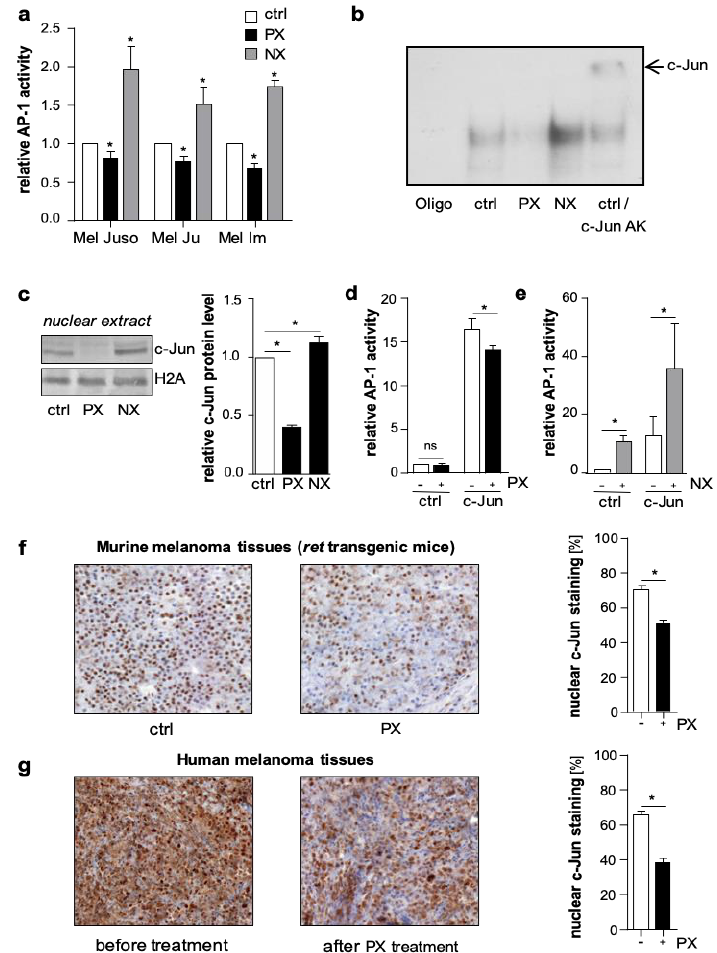
Figure 1. Microtubule-targeting drugs (paclitaxel and nocodazole) affect activator protein 1 (AP-1) activity in melanoma cells in vitro and in vivo. ( a ) Analyses of AP-1 luciferase reporter gene activity of human melanoma cells Mel Juso, Mel Ju, and Mel Im after treatment with the microtubule-stabilizing agent paclitaxel (PX; 5 µ M) or nocodazole (NX; 30 µ M), an agent promoting disruption of microtubule assembly. Control cells (ctrl) were treated with solvent DMSO (Dimethyl sulfoxide). ( b ) Electrophoretic mobility shift assays (EMSA) with nuclear extracts of PX or NX treated Mel Ju cells using the classical AP-1 consensus sequence (Oligo). Supershift experiments with an anti-c-Jun antibody demonstrate